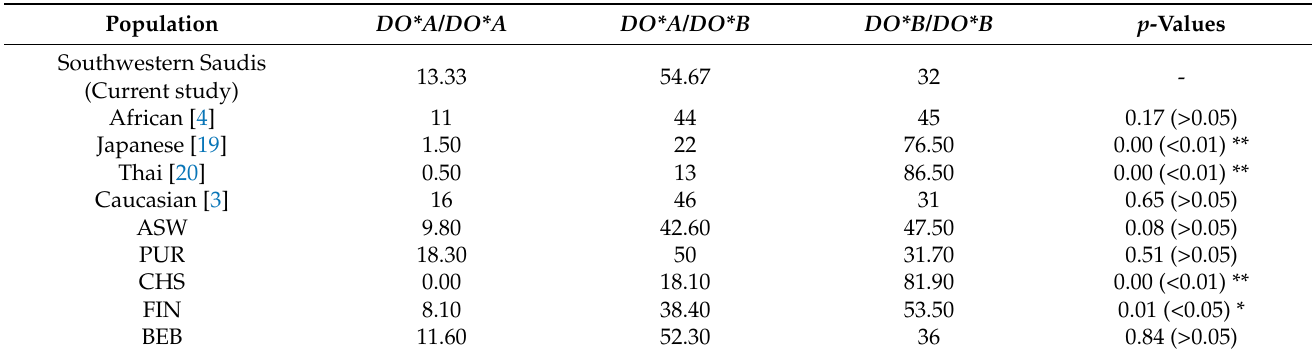
Table 4. Comparison of frequencies of DO phenotypes between multiple ethnic groups and the population evaluated in the present